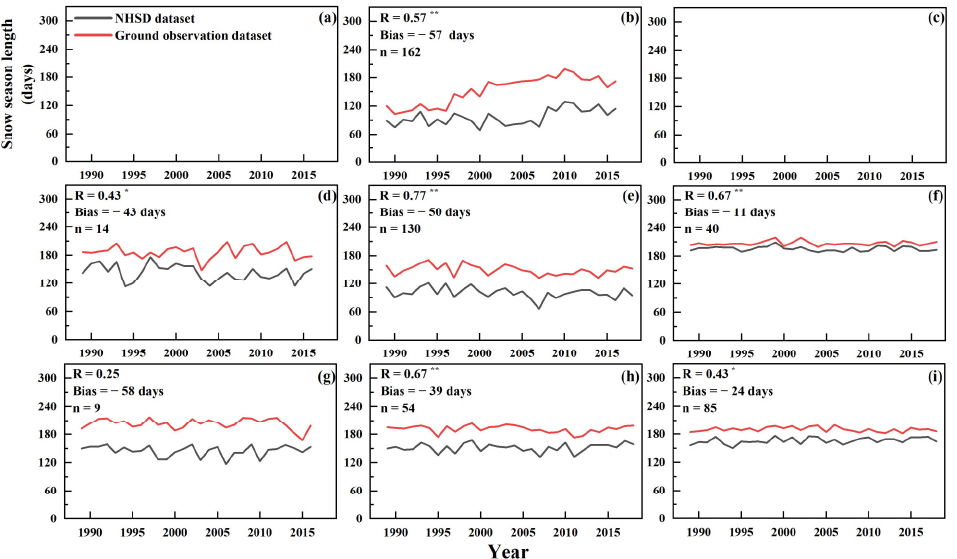
Figure A1. Comparison of the SSL derived from NHSD and ground observation datasets in typical areas. The typical areas are ( a ) the Alps, ( b ) the Rocky Mountains, ( c ) the Qinghai–Tibet Plateau, ( d ) Alaska, ( e ) the Eastern European Plain, ( f ) the Eastern Siberian Mountains, ( g ) Northern Canada, ( h ) the West Siberian Plain, and ( i ) the Central Siberian Plateau. The vertical axis labels in panels ( b – i ) are the same as those in panel ( a ). * and ** indicate that the correlation were significant at the 95% and 99% confidence level, respectively.